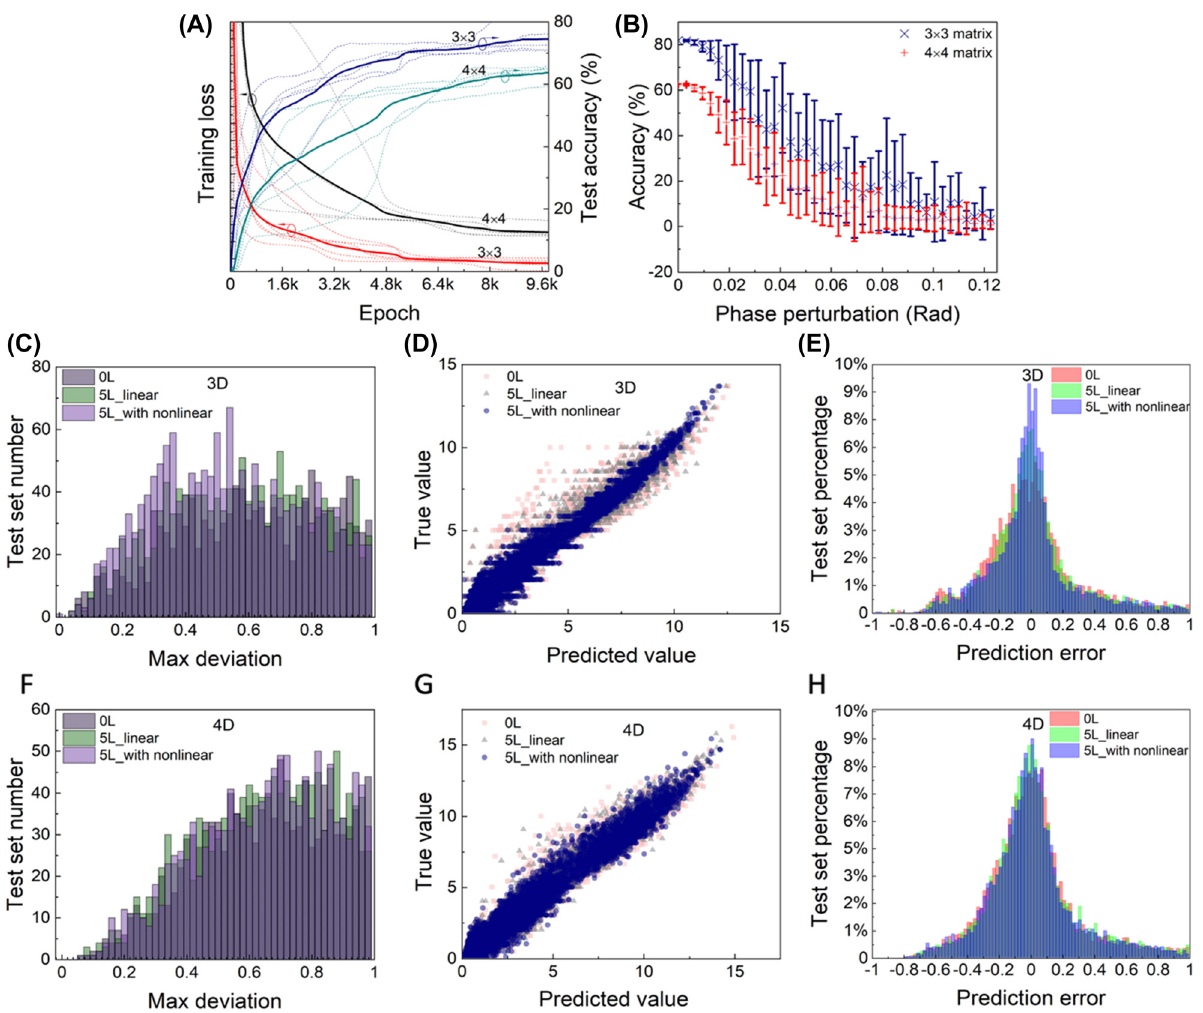
Figure 3: Performance of higher order matrix eigenvalue solvers. (A)Traininglossandtestaccuracyversustrainingepochofthe3 × 3and4 × 4problemswiththecon fi gurationof5Lwithnonlinear.Solidlines represent average loss of 5 training attempts depicted by dotted lines. (B) Test accuracy reduction of the 3 × 3 and 4 × 4 problems under random phase perturbation on phase shifters. Error bar represents standard variance of 20 random attempts. (C, F) Distribution of the max deviationofthe3 × 3and4 × 4problem,respectively,whicharecutoffafterthedeviationof1.(D,G)Correlationbetweenthetruevalueandthe predicted value for 0L, 5L, and 5L with nonlinear condition for 3 × 3 and 4 × 4, respectively. (E, H) Relative deviation for 0L, 5L, and 5L with